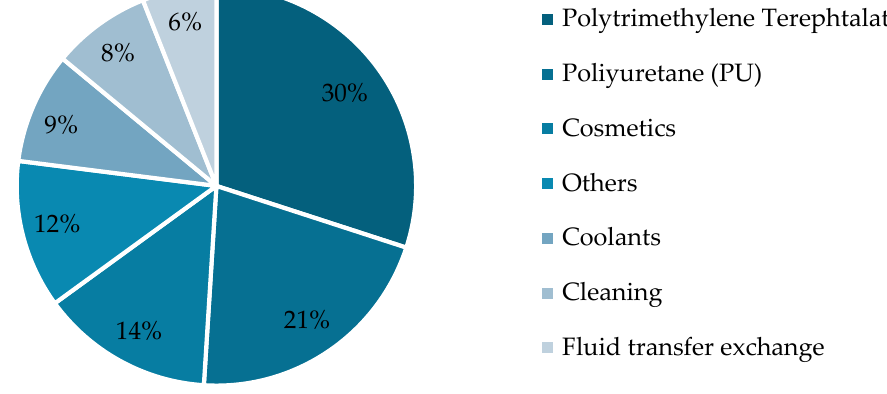
Figure 7. The main 1,3-PG applications. Currently, 30% of 1,3-PG production is used to manufacture polytrimethylene tereph- thalate (PTT) from terephthalic acid (Scheme 4), a polymer used in the manufacture of textile fibers and carpets due to its chemical resistance, stability, elastic recovery, and dyeing capacity. In addition, this polymer could be used as a substitute for polyethylene terephthalate (PET) and polybutene terephthalate (PBT), both from the petrochemical industry [23–25].